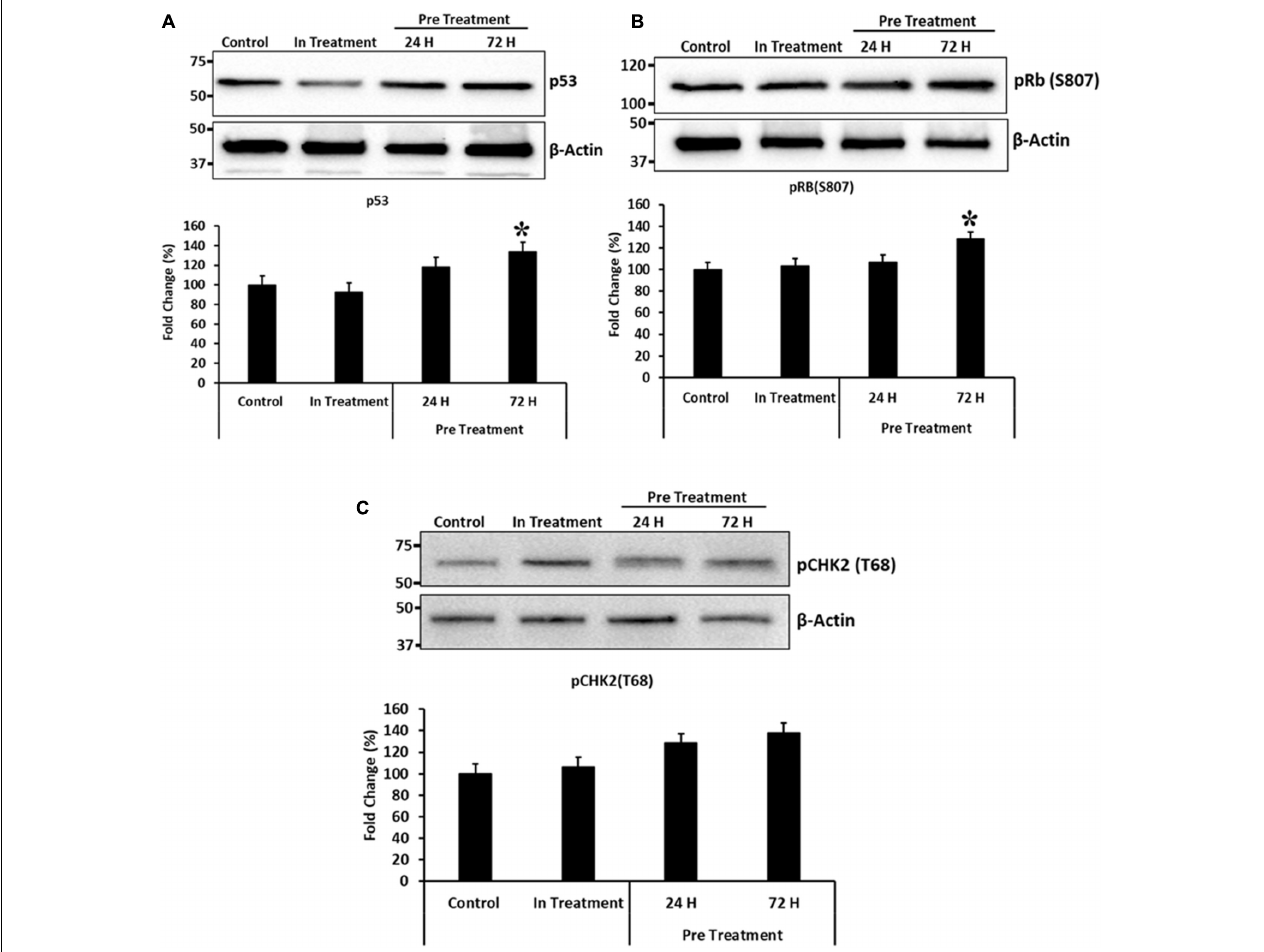
FIGURE 8 | Immunoblotting for selected proteins involved in cell cycle regulation. Immunoblotting was performed on preconditioned, in-treatment, and untreated control CV-MSCs. Expression levels of p53 and phosphorylation of Rb(S807) proteins (A,B) , increased significantly at 72 h of preconditioning, as compared to the CV-MSCs preconditioned for 24 h, in-treatment and untreated controls. Although there was an increase in phosphorylation levels for CHK2(T68) protein (C) at 24 and 72-h post preconditioning as compared to in-treatment and untreated control, yet the levels were not statistically significant. Experiments were conducted in triplicate using cells prepared from five placentae. Bars represent standard errors and (*) represent the significance of the results ( P ≤